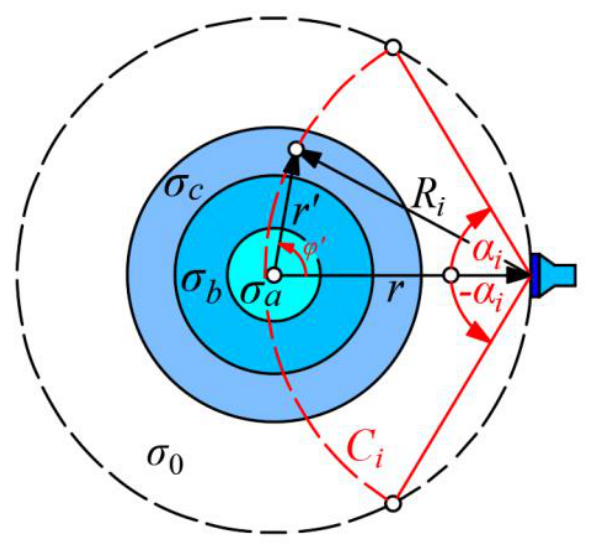
Figure 4. Schematic diagram of the MAT-MI system for the determination of the acoustic pressure.